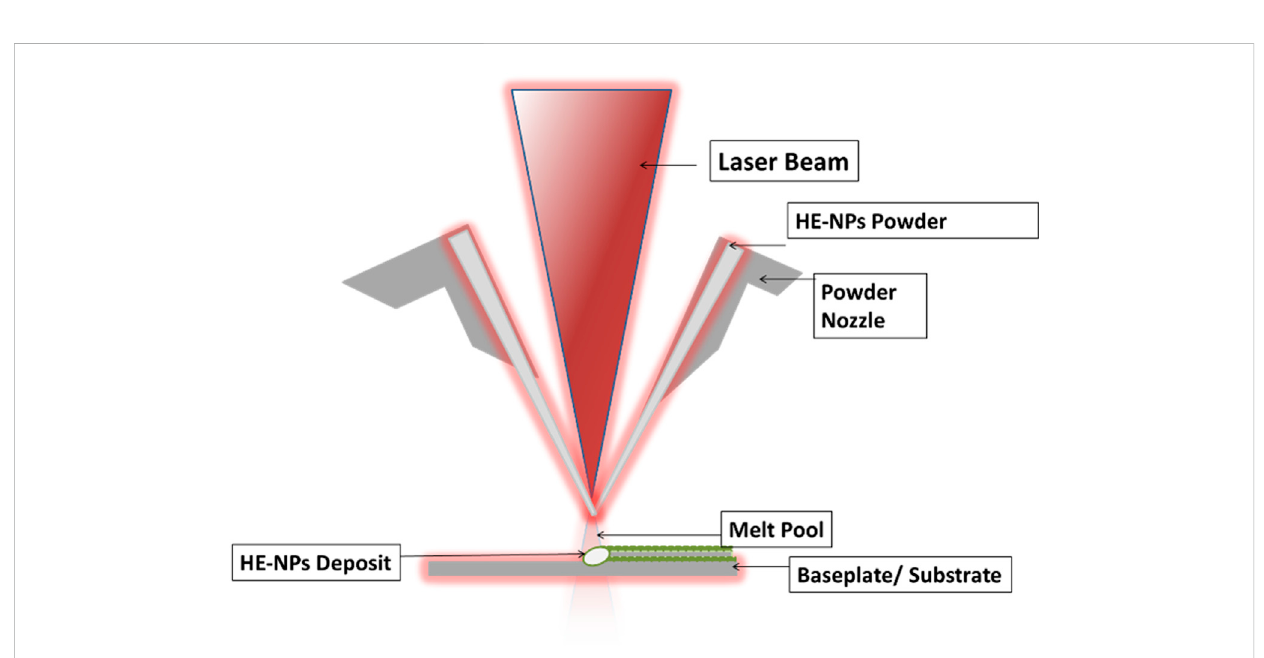
FIGURE 2 Schematic of the laser cladding